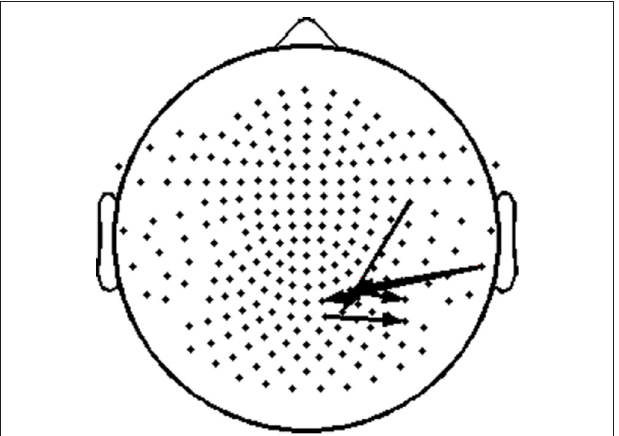
FIGURE 8 | Topography layout of the five pairs of sensors, located over right temporo-parietal regions, where significant positive correlations were found between TR values and reading measures among RD participants.